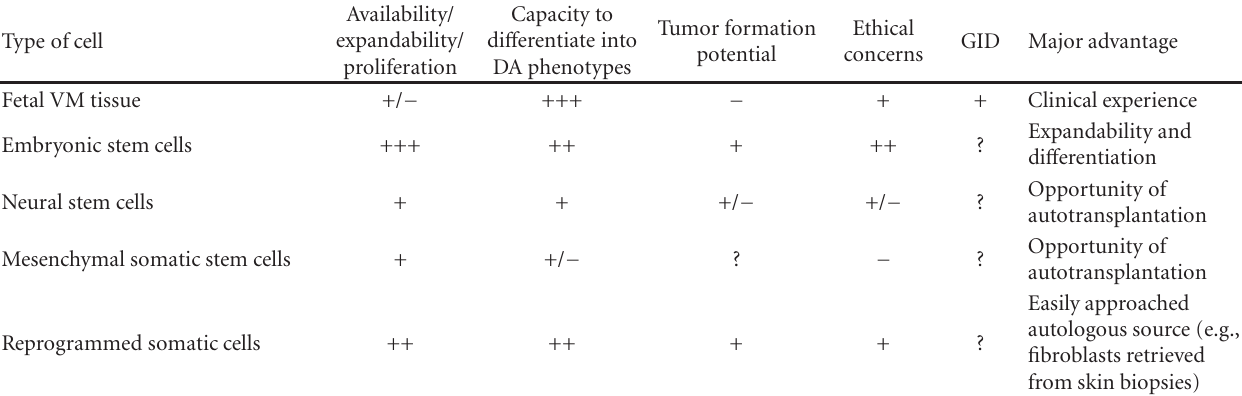
Table 1: Comparison of tissue/cell sources for cell replacement strategies in